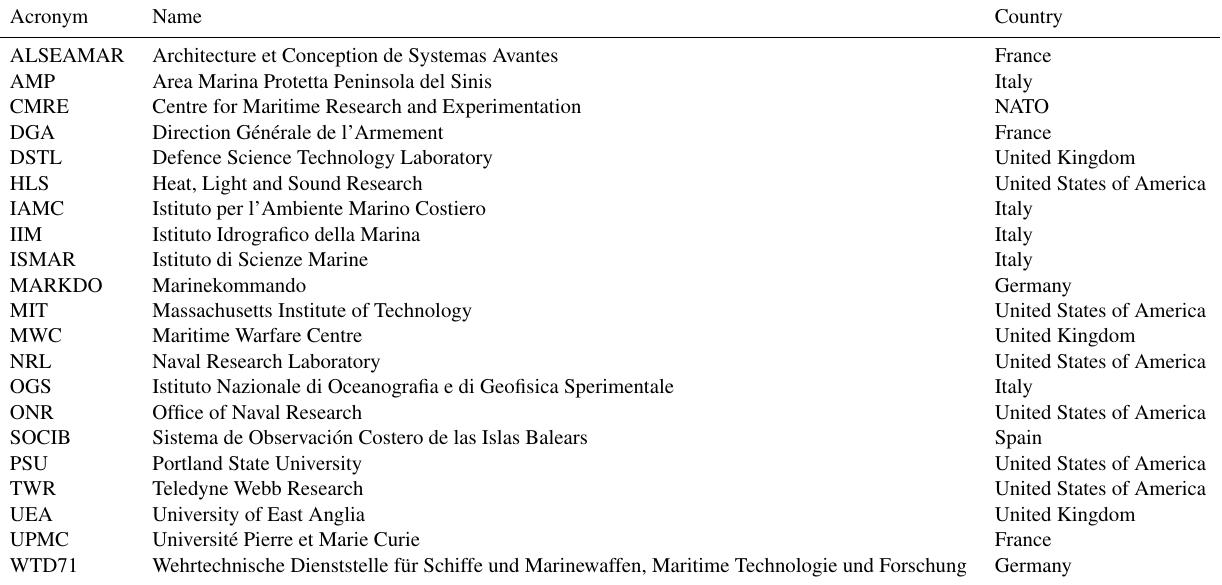
Table 1. Partners of the